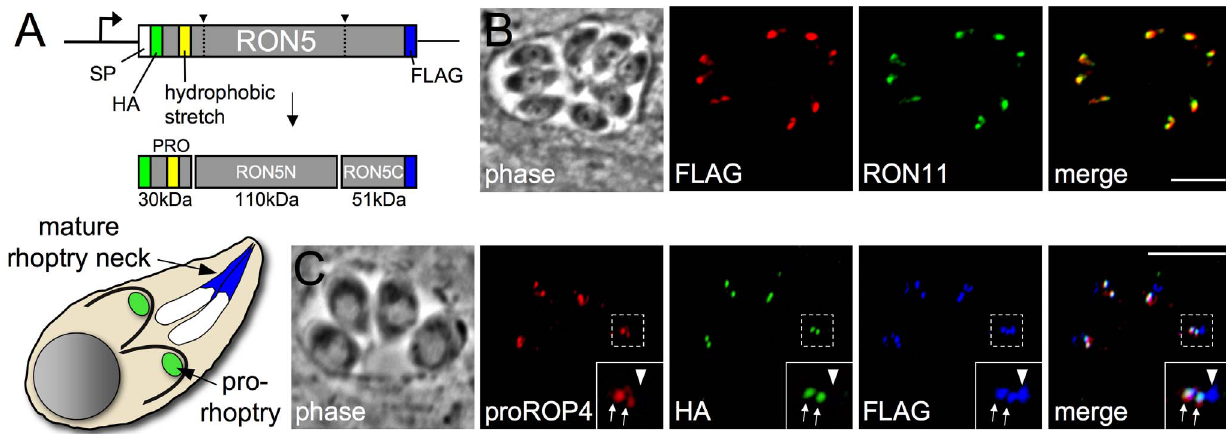
Figure 1. The N-terminus of RON5 is a pro domain that is not incorporated into the mature MJ complex. (A) Diagram showing RON5 double epitope tagging strategy. An HA tag was inserted inframe immediately downstream of the signal peptide and a FLAG tag was fused to the 3 9 end of the coding sequence. This HA-N-RON5-C-FLAG second copy was targeted to the UPRT locus under the control of the endogenous RON5 promoter. A predicted hydrophobic stretch within the N-terminal region of RON5 is shown in yellow. (B) IFA showing RON5C-FLAG signal colocalizes with RON11 in the rhoptry neck. Red: mouse anti-FLAG antibody detected by Alexa594-anti-mouse IgG. Green: rat anti-RON11 antibody detected by Alexa488-anti-rat IgG. (C) IFA showing localization of the double epitope tagged RON5 protein during rhoptry maturation. The N-terminal portion of RON5 tagged with HA (green) co-localizes with proROP4 (red), indicating it is present in the pro-rhoptry compartment (arrows). RON5C-FLAG (blue) is present in the pro-rhoptry as well but also labels the mature rhoptries (arrowhead), visible as a distinct compartment anterior to the pro-rhoptries in each cell that does not contain proROP4. Importantly, the HA signal never co-localizes with the FLAG signal in the absence of proROP4, indicating it is not present in the mature rhoptries. Red: rabbit anti-proROP4 antibody detected by Alexa594-anti-rabbit IgG. Green: rat anti-HA antibody detected by Alexa488-anti-rat IgG. Blue: mouse anti-FLAG antibody detected by Alexa350-anti-mouse IgG. All scale bars=5 m m.